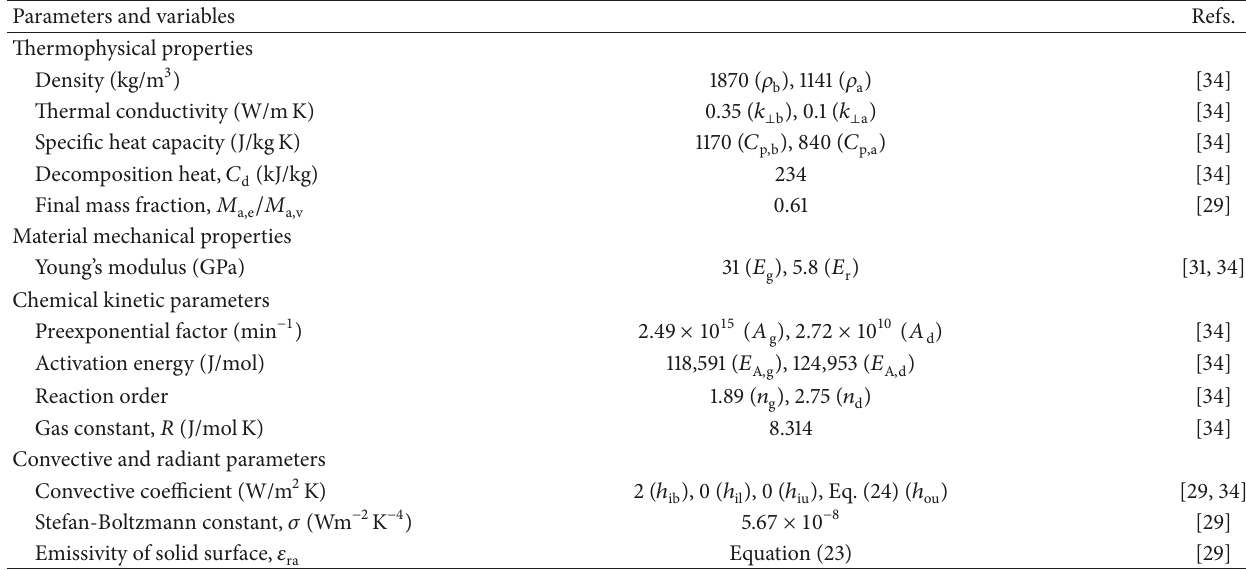
Table 1: Parameters and variables used in numerical